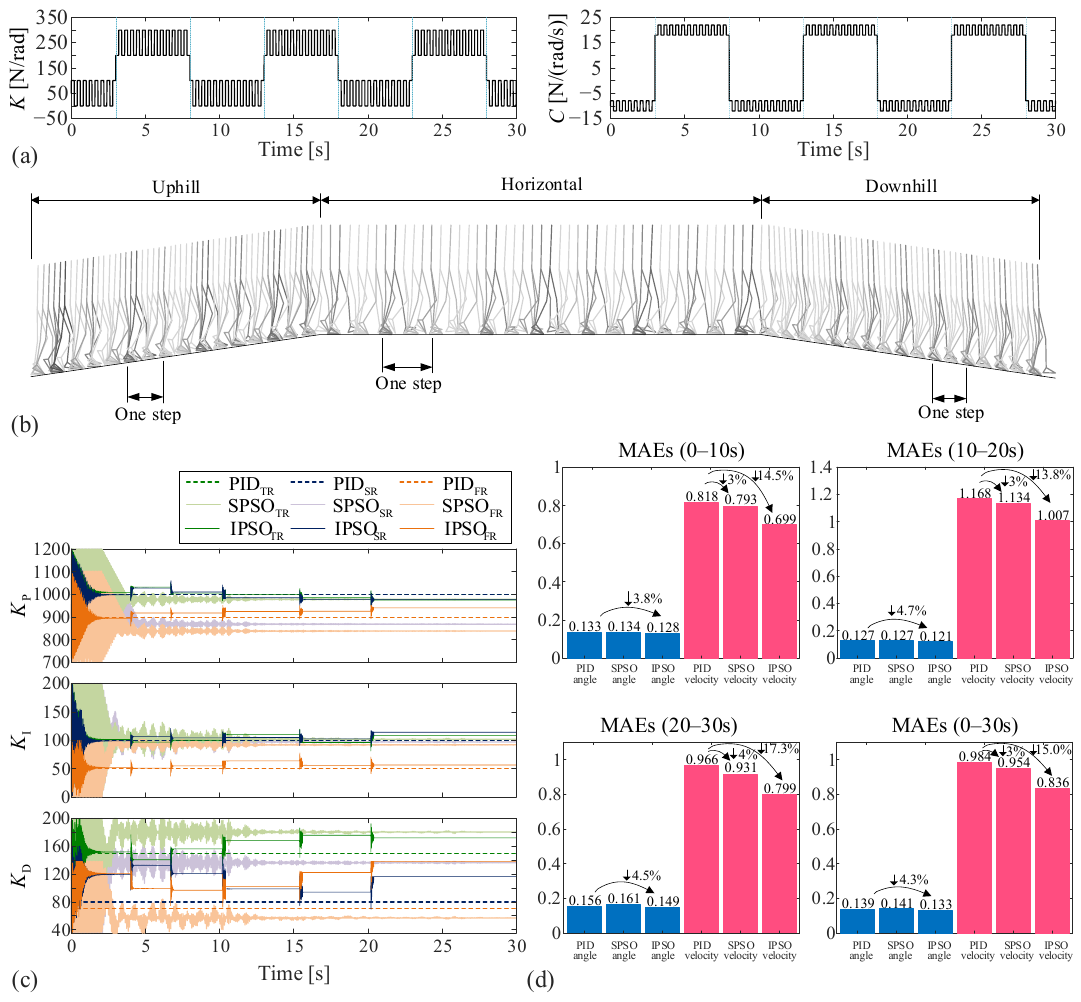
Figure 6. Tracking results of Case III. ( a ) Fast and slow variations of the stiffness and damping of the exoskeleton joints. ( b ) Stroboscopic view of dynamic walking in different terrains, including upslope (0–10 s), level road (10–20 s), and downslope (20–30 s). ( c ) Evolutions of the PID gains corresponding to the SPSO and the IPSO algorithms; for reference, the pre-tuned PID gains are also plotted. ( d ) Mean accumulated errors (MAEs) in the three stages and the whole process (0–30 s). The reductions brought by SPSO and the IPSO algorithm are denoted.